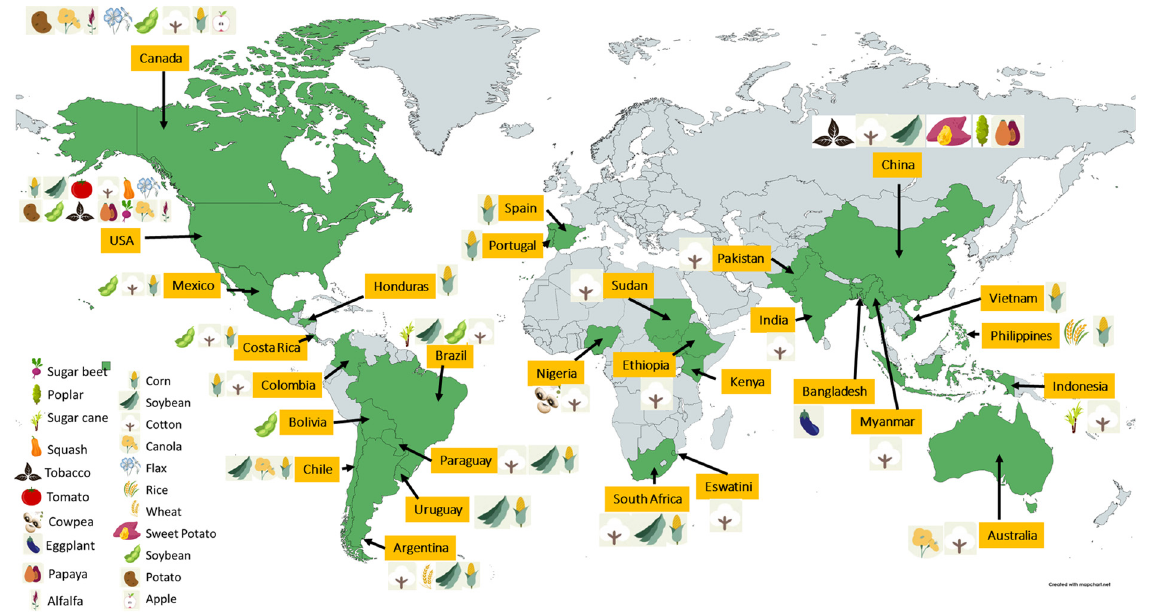
Figure 6. Countries that commercially grow genetically modified crops. This infographic was cre- ated based on the Genetic Literacy Project and other resources: International Service for the Acqui- sition of Agro-biotech Applications, Wikipedia, and Crop Life International websites [200–